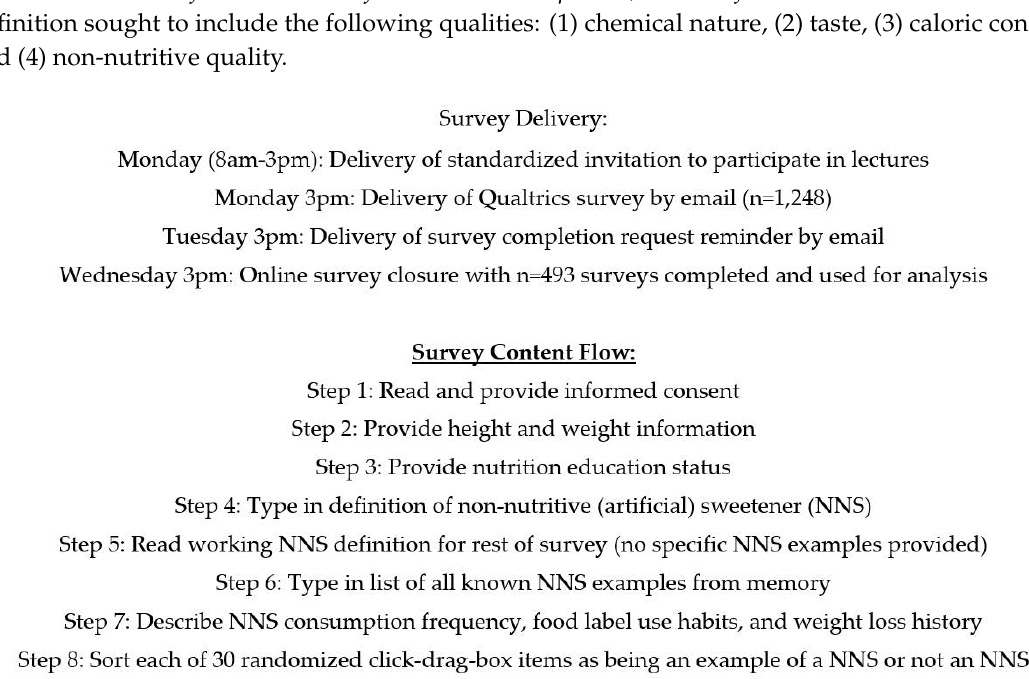
Figure 1. Sequence of online survey delivery and content